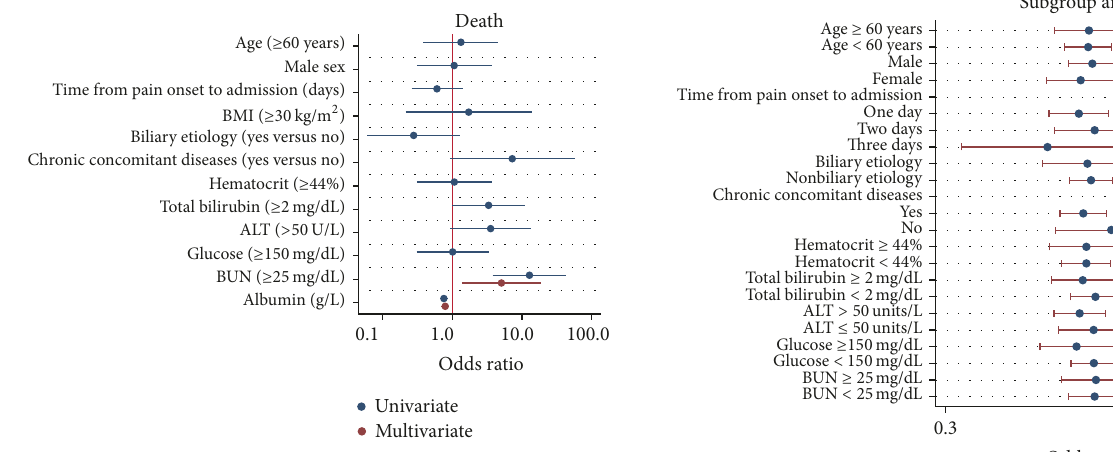
Figure 3: Univariate and multivariate logistic regression plot of odds ratios and 95% confidence intervals for evaluation of the relationship between serum albumin level and death in acute pancreatitis.